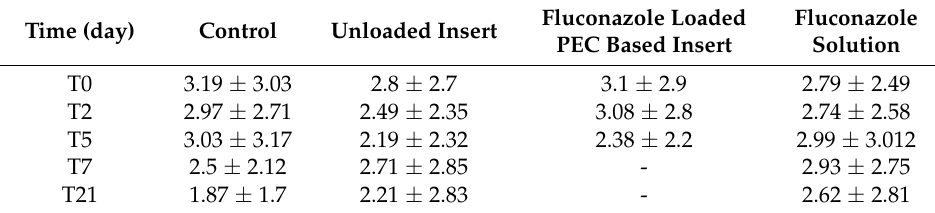
Table 2. Viability of Candida albicans in swabs from vaginal rats inoculated with fluconazole loaded PECs based vaginal inserts (F17) in comparison to unloaded insert and fluconazole solution.